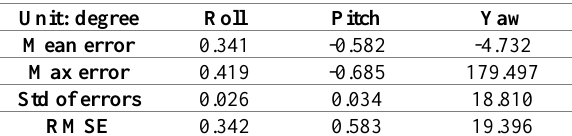
Table 6 .Accuracy of angles during conducting initial alignment with original data and parameters of the IMU error model in user